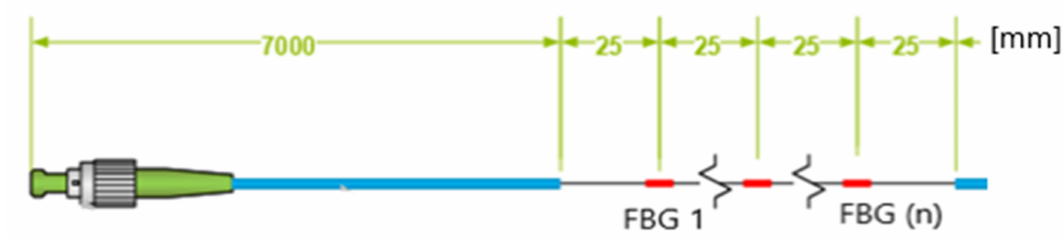
Figure 6. Scheme of fibre Bragg grating (FBG) sensor (mm) .